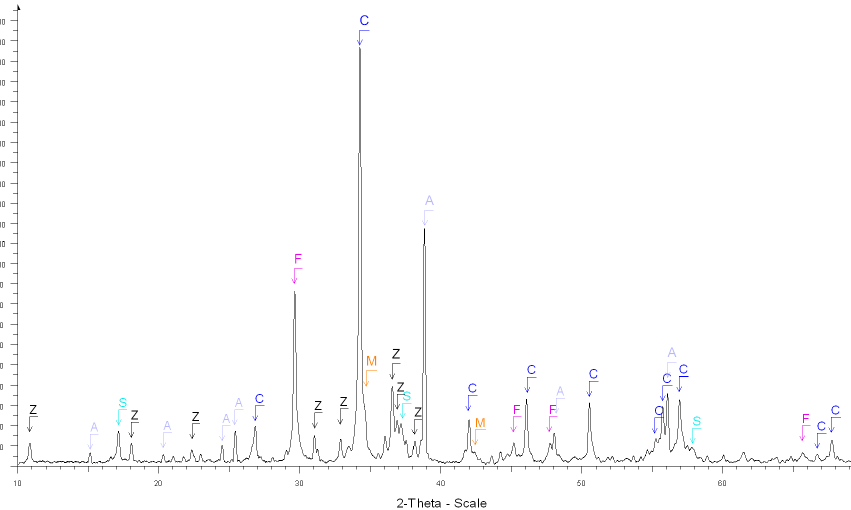
Figure 2. XRD diffractograms: After the dissolution of white cement. C, F, Z, S, A and M stand for calcite, calcium sulfate, syngenite, calcium sulfate hydrate, calcium sulfate hydrate, portlandite and calcite magnesian, respectively.